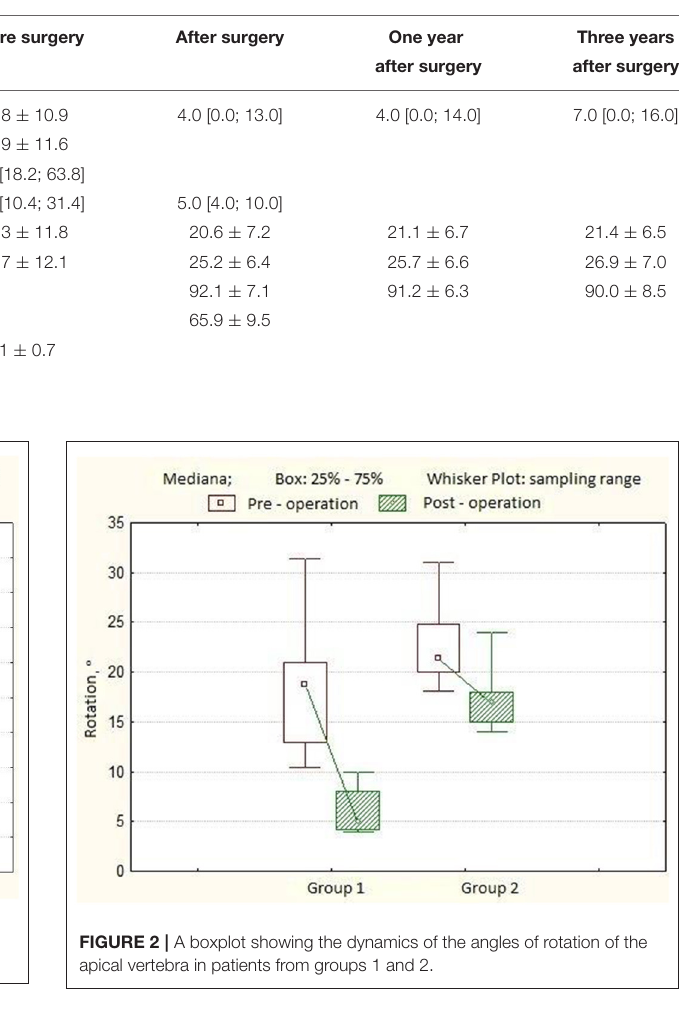
lumbar region is 25.2 ◦ ± 6.4 ◦ . The rotation of the apical vertebra was 5.0 ◦ ± 1.3 ◦ (4.0 ◦ -10.0 ◦ ), the percentage of derotation was 65.9 ± 9.5%. The length of the hardware is 11 ± 0.7 (10–12) vertebrae. The number of transpedicular support elements per patient varied from 20 to 24, with an average of 21 screws. Twelve months after the surgery, the magnitude of the scoliotic curve was 4 ◦ (0.0 ◦ -14.0 ◦ ), the angle of kyphosis was 21.1 ◦ ± 6.7 ◦ , and angle of scoliosis was 7 ◦ (0 ◦ -16 ◦ ), the magnitude of kyphosis was 21.4 ◦ ± 6.5 ◦ , and the angle of lordosis was 26.9 ◦ ± 7.0 ◦ ( Table 1 ). ranged from 51 ◦ to 79 ◦ (mean 64.4 ◦ ± 9.9 ◦ ), kyphotic angle— from 7 ◦ to 40 ◦ (mean 18.9 ◦ ± 8.2 ◦ ), the magnitude of lordosis vertebra—from 18.1 ◦ to 31.0 ◦ (mean 21.4 ◦ ± 2.6 ◦ ). After the operation, the angle of scoliotic deformity of the spine was 10.5 ◦ ± 3.1 ◦ (6.0 ◦ -19.0 ◦ ); the percentage of correction is 81.8 ± 6.3% ( Figure 1 ). The angle of kyphosis in the thoracic region is 23.4 ◦ ± 5.1 ◦ , the angle of lordosis in the lumbar region is 28.2 ◦